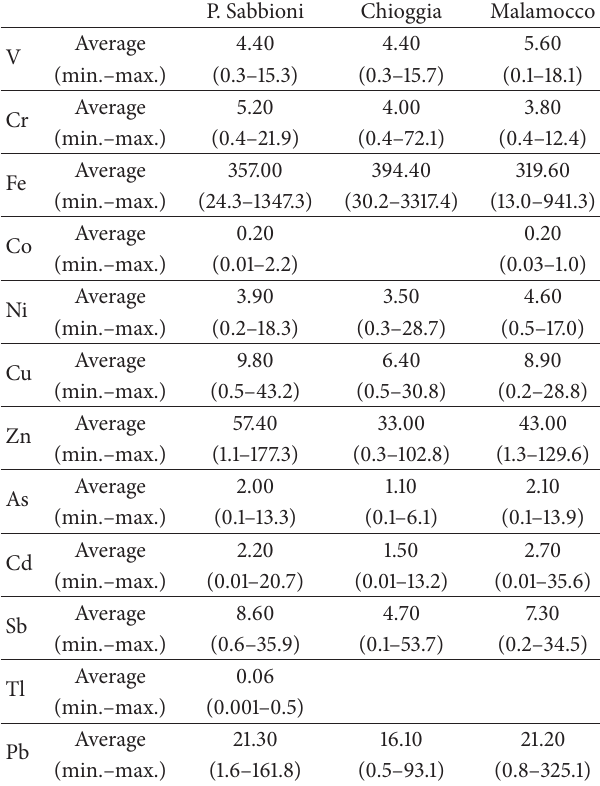
Table 2: Concentrations (ng/m 3 ) of elements in PM10 measured in the three sites